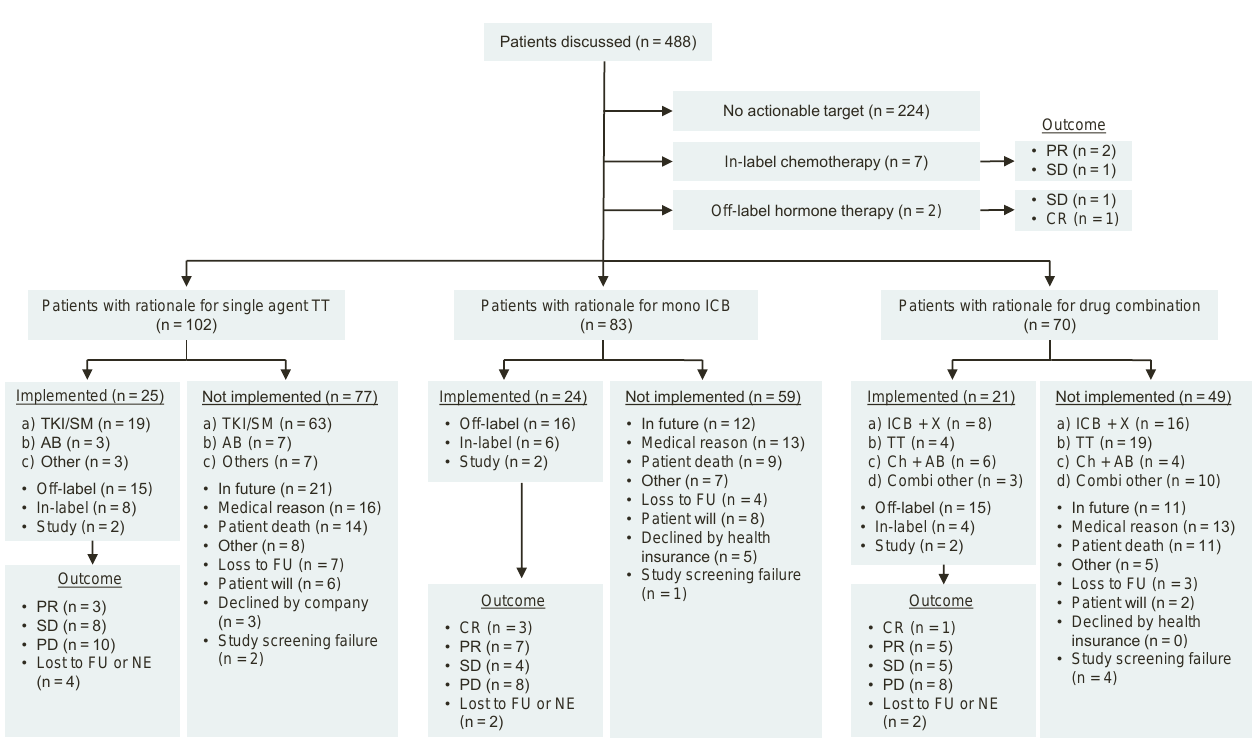
Figure 2. Flow diagram of patients discussed at the MTB. Responses were determined according to Response Evaluation Criteria in Solid Tumors (RECIST) version 1.1.; (a–d) represent various drug categories as indicated. PR = Partial remission. SD = Stable disease. PD = Progressive disease. ICB = Immune checkpoint blockade. TT = Targeted therapy. TKI = Tyrosine kinase inhibitor. SM = Small molecule. AB = Antibody. ICB + X = Combination of immune checkpoint blockade with another drug. Ch + AB = Combination of chemotherapy with an antibody. FU = Follow-up. NE = Not